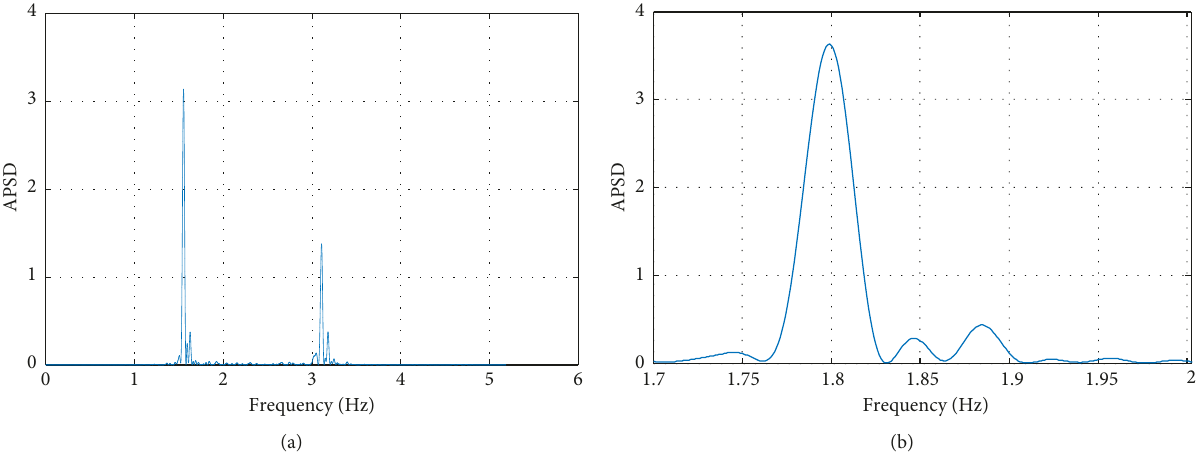
Figure 6: Power spectral density (PSD) of the clavicle acceleration of Participant No.18 bouncing at 1.8Hz. The corresponding time series is visualized in Figure 5. (a) Full view; (b) Zoom view.